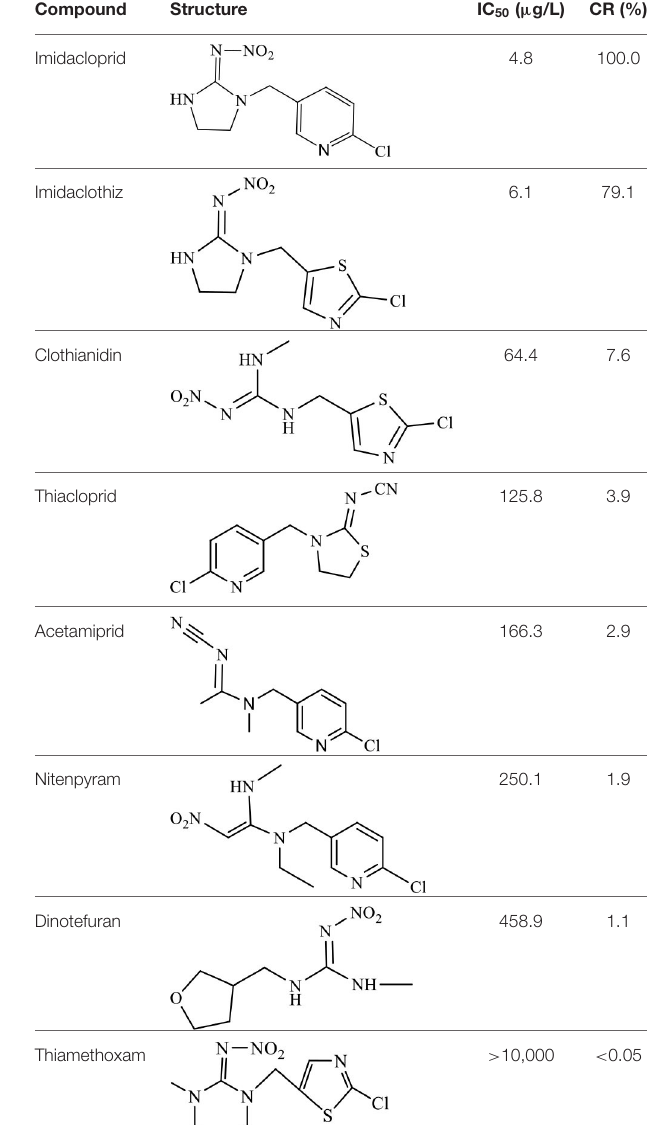
FIGURE 2 | The standard curve of FPIA for IMI.